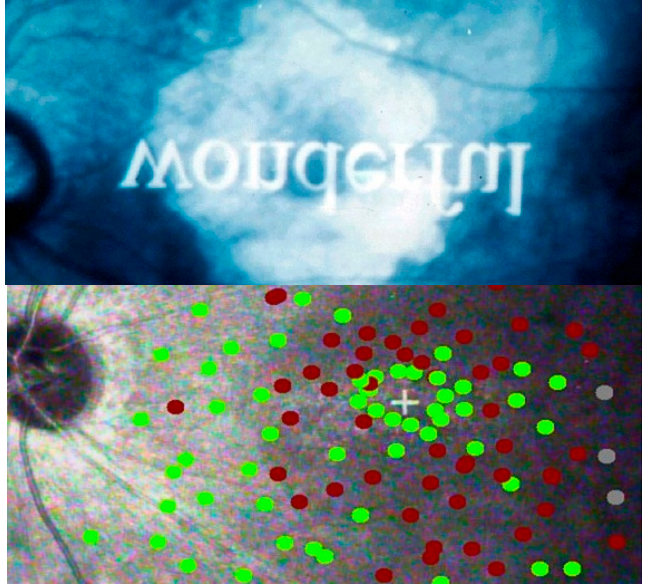
Figure 15. Ring scotoma Top: recognizing letters, but not words. Bottom: Micro-perimetry. Green = points seen; red = points missed. + = fixation.